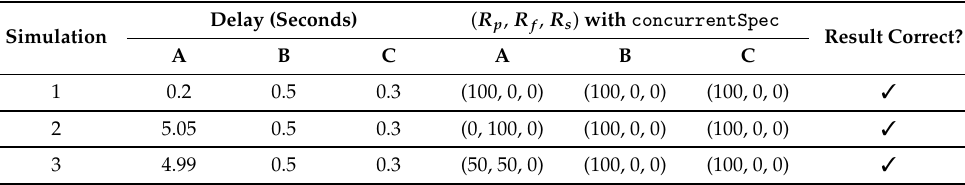
Table 3. Simulation results of executing the scheduled sprinkling specification in Figure 2 with concurrentSpec , where R p , R f , and R s is the number of times the assertion passes , fails , or is skipped , respectively. Each simulation is repeated 100 times.